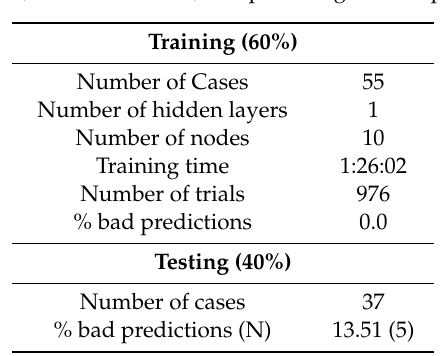
Table 2. Characteristics and principal results of the multilayer feed forward artificial neural network (MLFN) model (training and internal test) in predicting the classification of Italian vs. foreign EVOO: number of cases, training time, number of trials, and percentage of bad